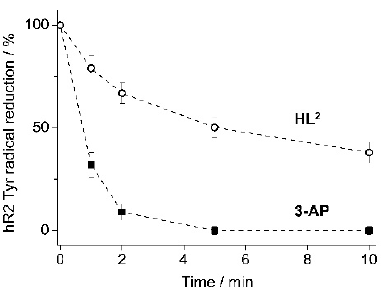
Figure 8. Tyrosyl radical reduction in human R2 RNR protein by 3-AP and HL 2 in the presence of an external reductant. The samples contained 20 μ M hR2 in 50 mM Hepes buffer, pH 7.60/100 mM KCl/5% glycerol, and 20 μ M 3-AP or HL 2 in 1% ( v / v ) DMSO/H 2 O, and 2 mM dithiothreiotol (DTT). Error bars are the standard deviation from two independent experiments.